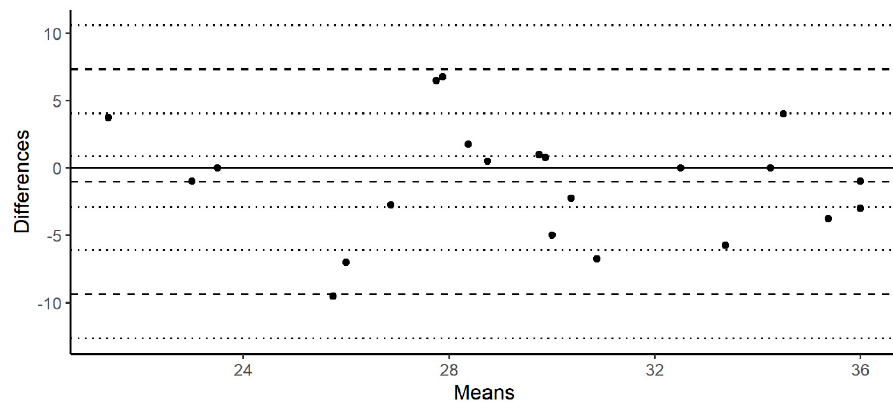
Figure 2. Bland − Altman plot for the test − retest TDI score.